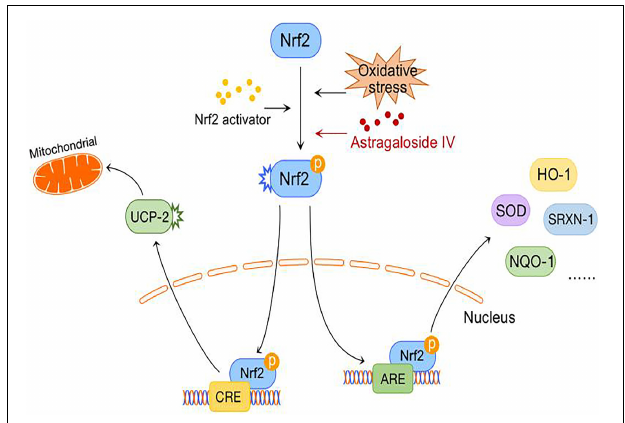
FIGURE 3 | Antioxidative stress mechanism of astragaloside